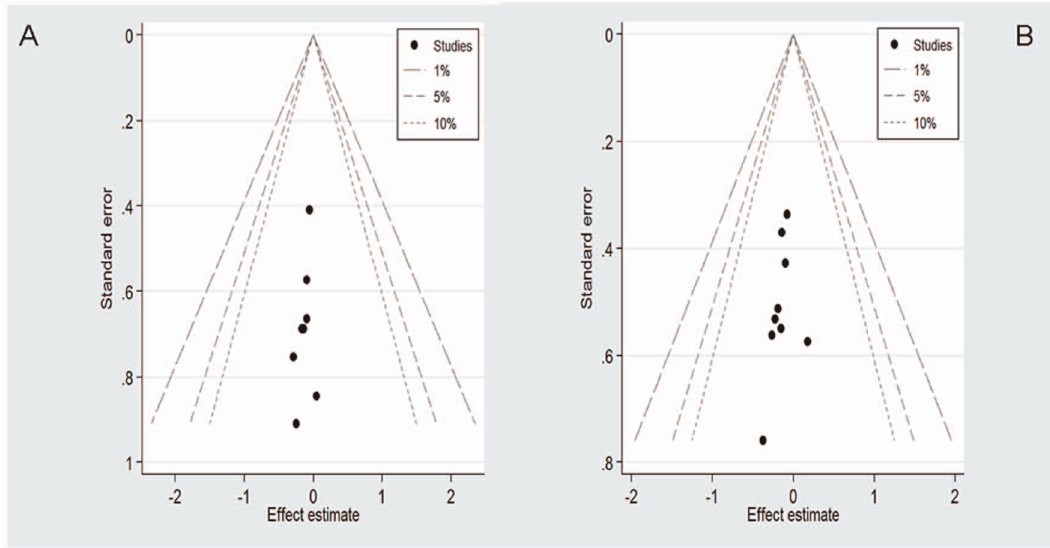
Figure 3. Contour-enhanced funnel plot for publication bias test. (A)Disease-free survival; (B) Overall survival.